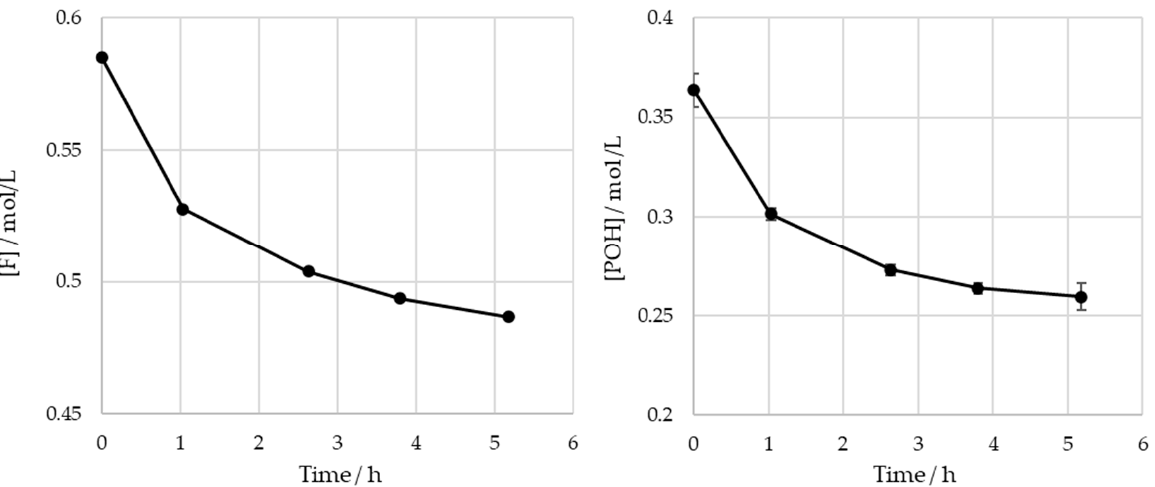
Figure 7. Consumption of formaldehyde and phenolic hydroxyl groups type I and II in the methylo- lation of SLS at 60 °C.